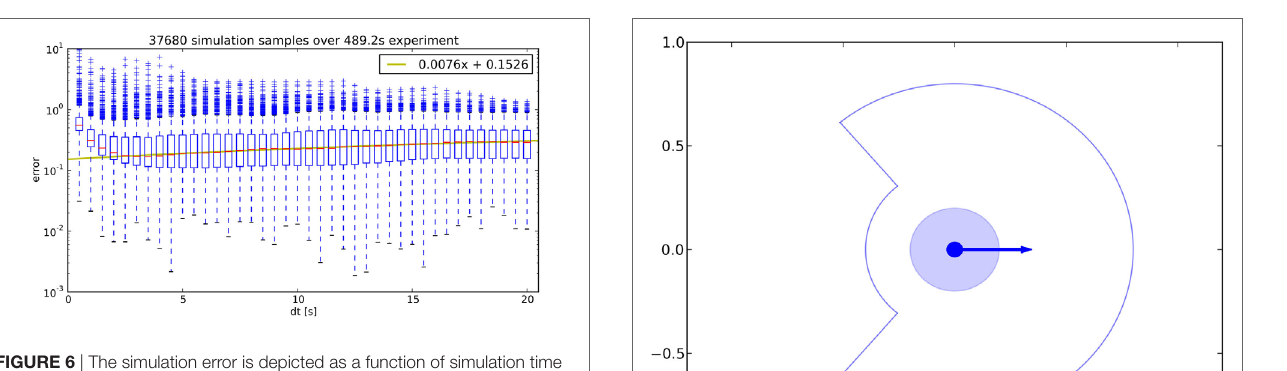
FigUre 6 | The simulation error is depicted as a function of simulation time on a logarithmic scale. A linear model for the median as a function of simulation time is also shown as a yellow line.